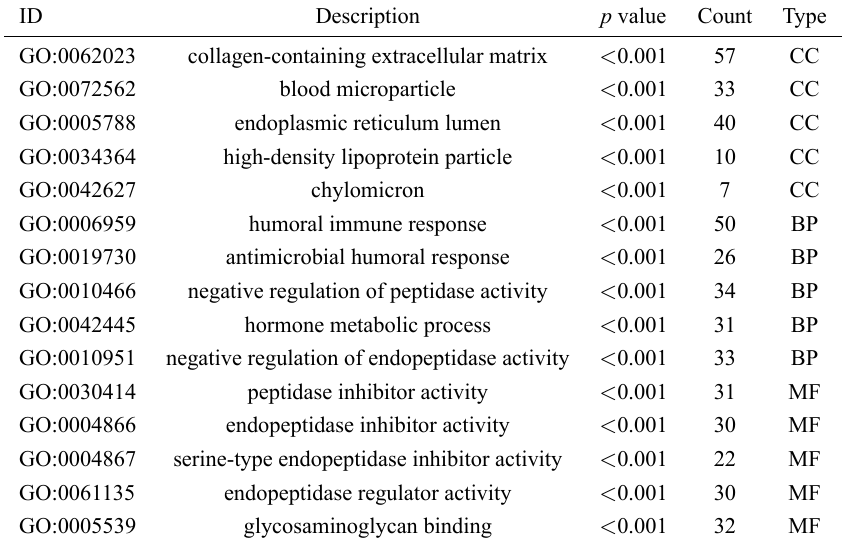
Table 1. Gene Ontology (GO) enrichment analysis of DEGs.